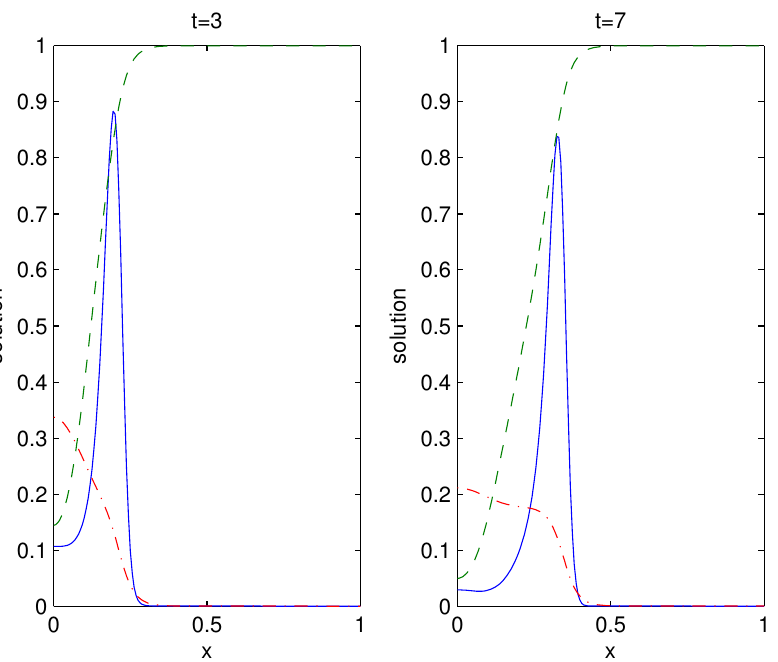
Figure 5. The solid line represents the density of cancer cells, the dashed line denotes the density of ECM, and the dashed and dotted line denotes the concentration of MDE at time t = 3 and t = 7. Solutions with the parameter value d n = 0.0002, Example